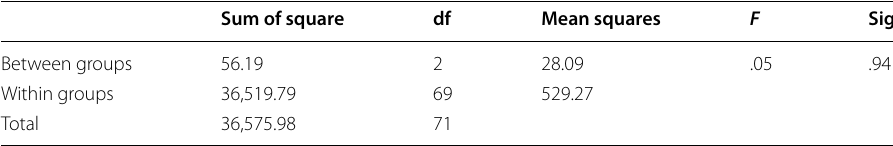
Table 12 Inferential statistics of the three groups on the motivation pre-tests Sum of square df Mean squares F Sig. Between groups 56.19 Within